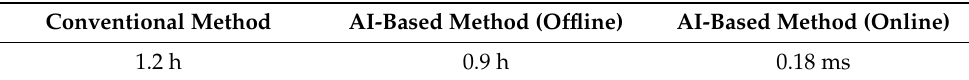
Figure 10. Performance of the developed AI-based stability assessment tool on the full 20,000-bus WECC system: ( a ) predicted frequency nadir using the random forest algorithm, ( b ) predicted frequency nadir using the neural network algorithm, ( c ) predicted CCT value using the random forest algorithm, ( d ) predicted CCT value using the neural network algorithm. Table 1. Time performance of conventional time domain simulation method and the proposed AI-based method for transient stability prediction.